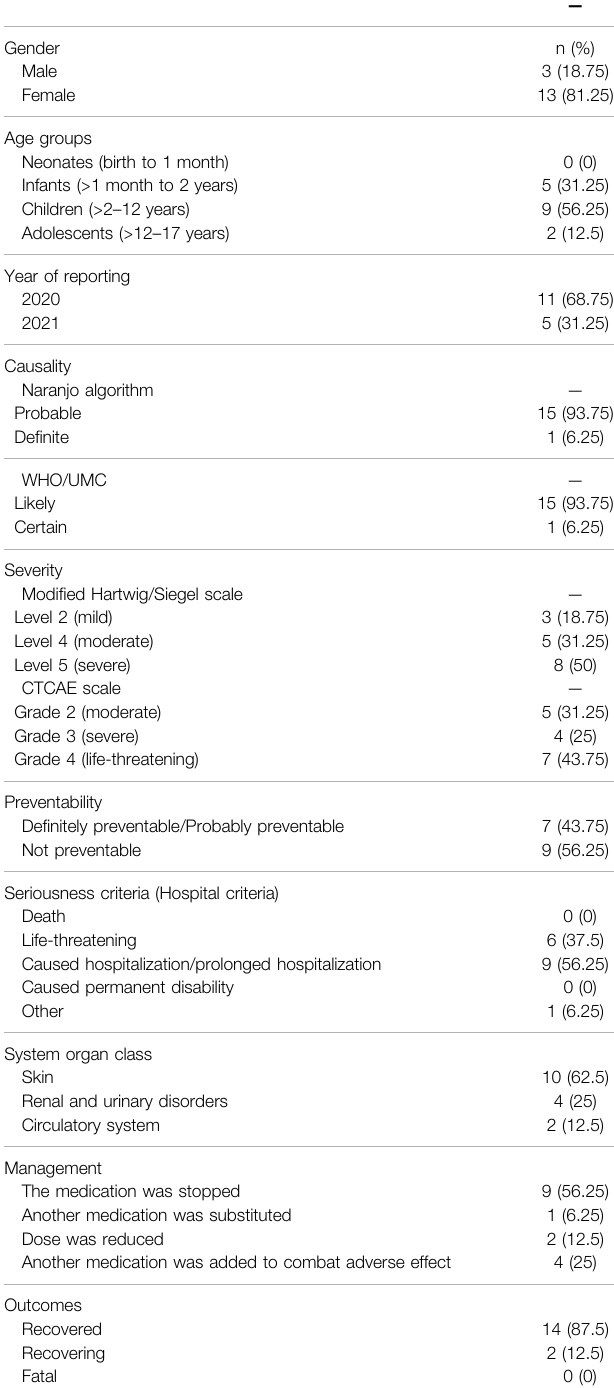
terminology criteria for adverse